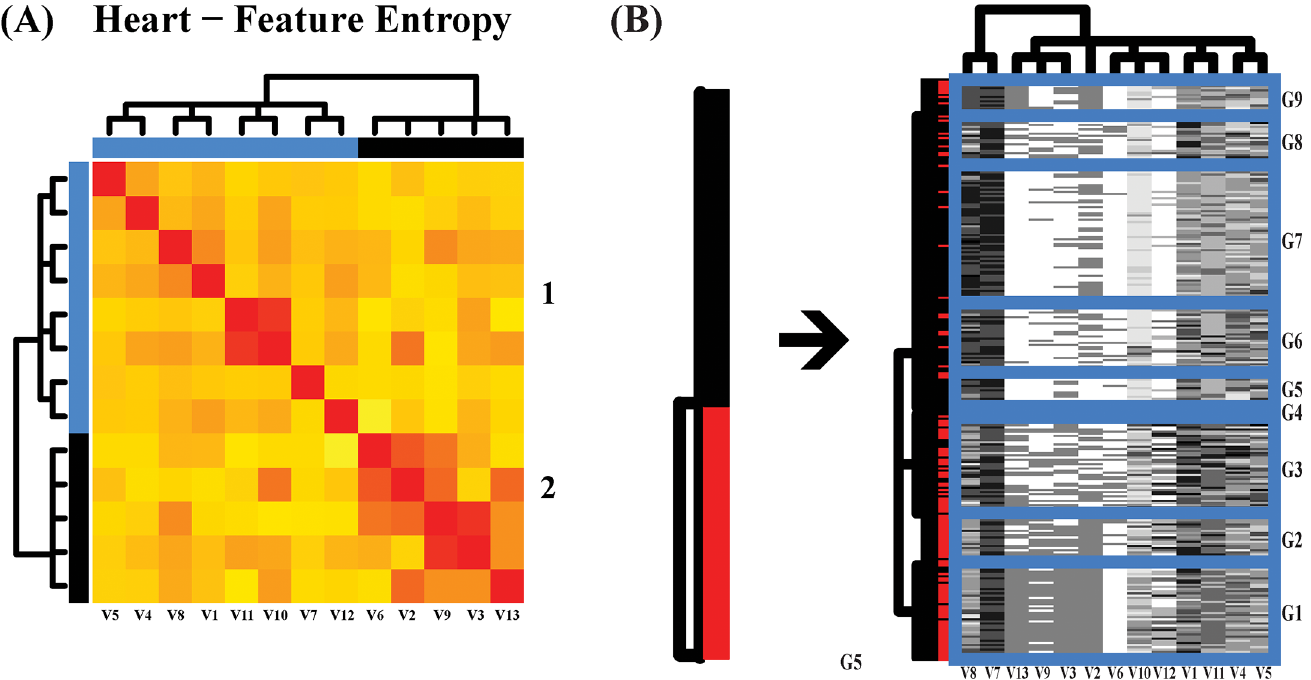
Fig 9. Heatmaps via DM on heart disease data. (a) Mutual entropy matrix of all features with two synergistic groups; (b) Coupling geometries of all features. Red color for patients, Black for healthy subjects.